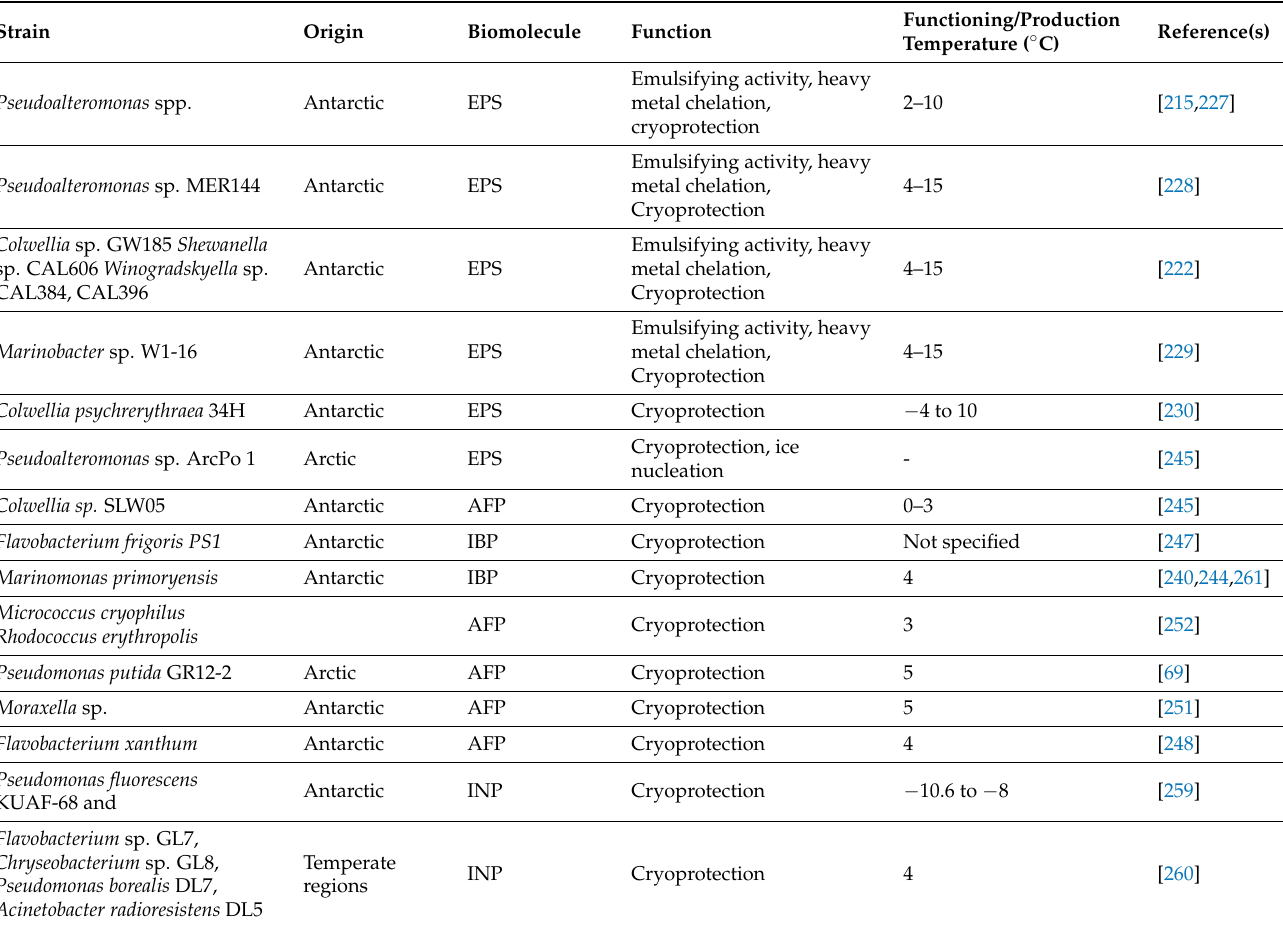
Table 1. Production of extracellular polymeric substances and ice-binding proteins by cold-adapted bacterial